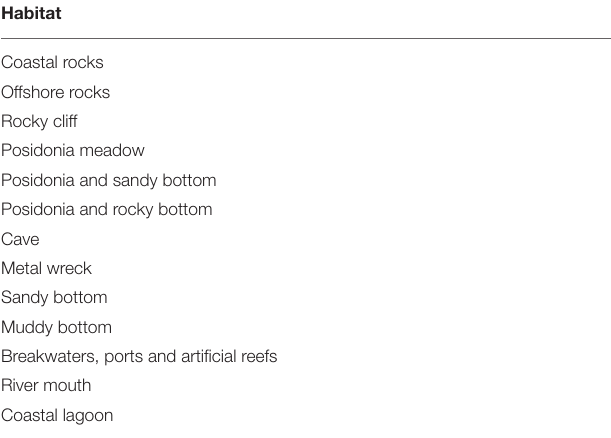
TABLE 3 | List of prevailing habitats considered.